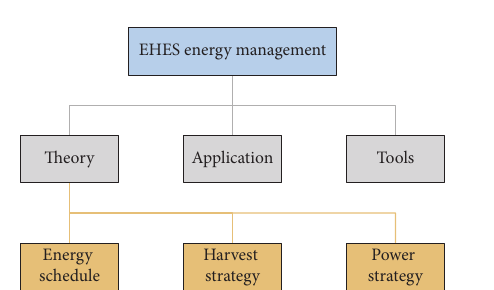
Figure 4: Taxonomy of research literature on EHES energy